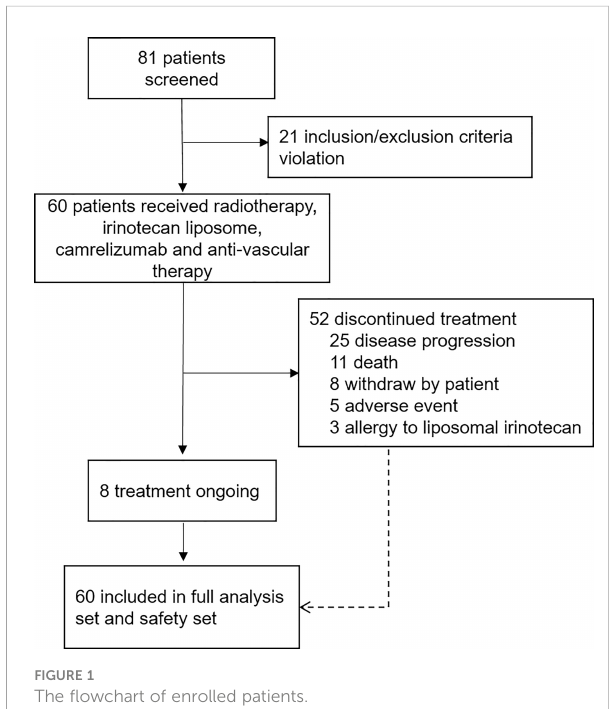
FIGURE 1 The fl owchart of enrolled